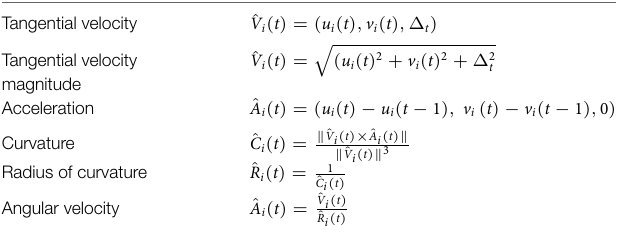
TABLE 1 | Empirical formulations of the spatio-temporal dynamic features ( ∆ t is the temporal displacement between observations of two adjacent time instants)